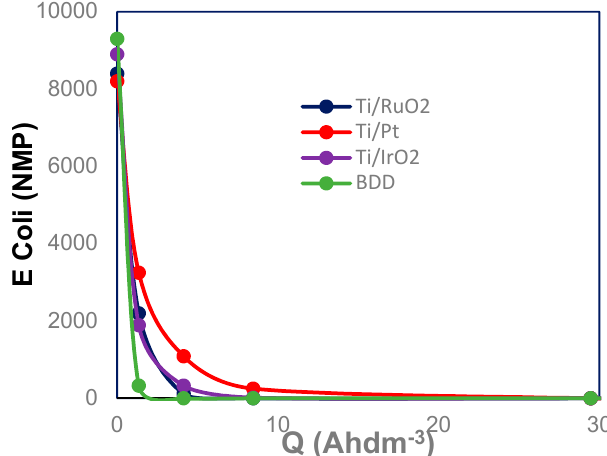
Figure 4. Variation of the E. coli concentration with the applied electric charge during the electrochemical treatment of urine wastewaters at four different anode materials (j = 15 mA cm − 2 ). E Coli: 8300-8700 MNP 100 mL − 1 , T: 25 °C, pH ≈ 8.00.